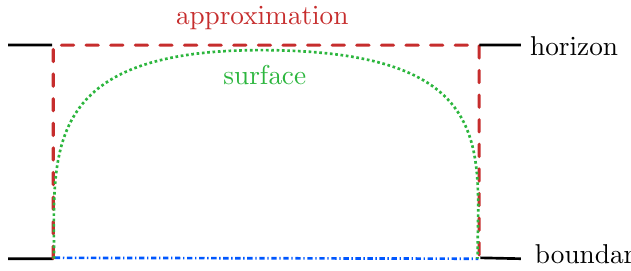
Figure 1. Large-width